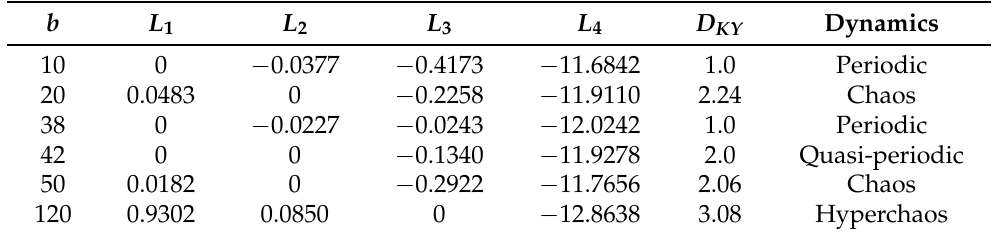
Table 1. Lyapunov exponents and Kaplan–Yorke dimension of system (2) with a = 10, c = 2.7, k = − 0.2, and m =